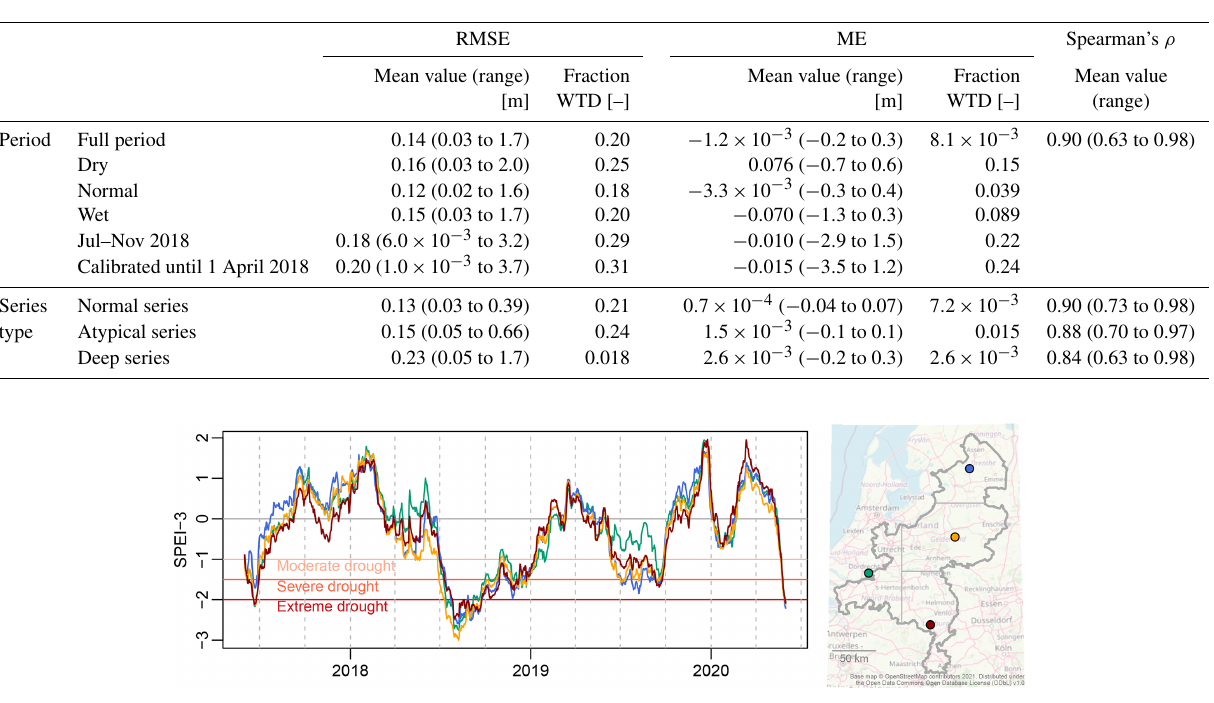
Figure 3. Development of the meteorological drought over 2018–2020 in the western, northern, central eastern, and south-eastern sections of the study area given by the 3-month SPEI. The map shows the four sections.